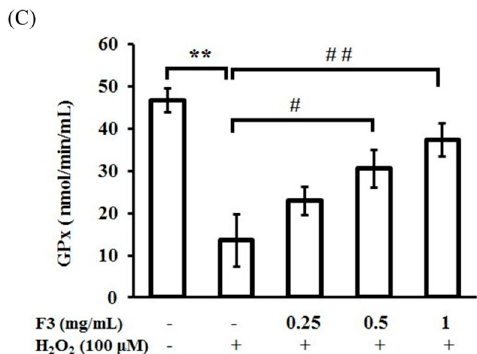
Figure 4. Effect of P. ginseng supercritical CO 2 extracted fraction F3 on cellular antioxidant enzymes: ( A ) superoxide dismutase (SOD); ( B ) catalase (CAT); and ( C ) glutathione peroxidase (GPx) activities